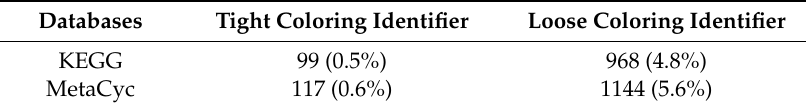
Table 8. Compounds with the same coloring identifier, excluding R groups.